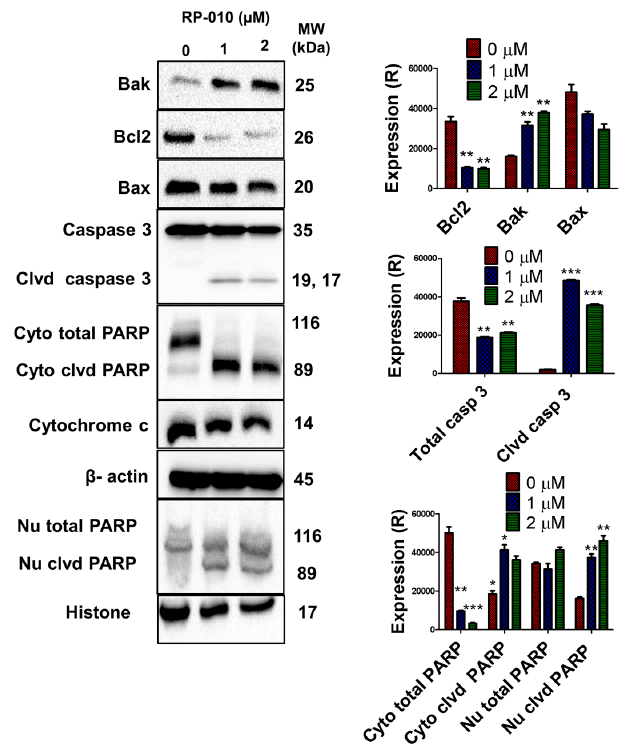
Figure 3. RP-010 activates the intrinsic apoptosis pathway. (Left) The effect of RP-010 (1 or 2 µM, at 24 h incubation) or vehicle on the expression levels of the apoptotis-regulating proteins Bak, Bcl2, caspase-3, cleaved caspase-3, cytosolic (“Cyto”) and nuclear (“Nu”) poly ADP-ribose polymerase (PARP), cytosolic and nuclear cleaved PARP, and cytochrome c, are shown. β -actin and histone were used as reference proteins. (Right) The histograms represent a quantitative summary of the results. (R) = relative. ** p < 0.01, *** p <